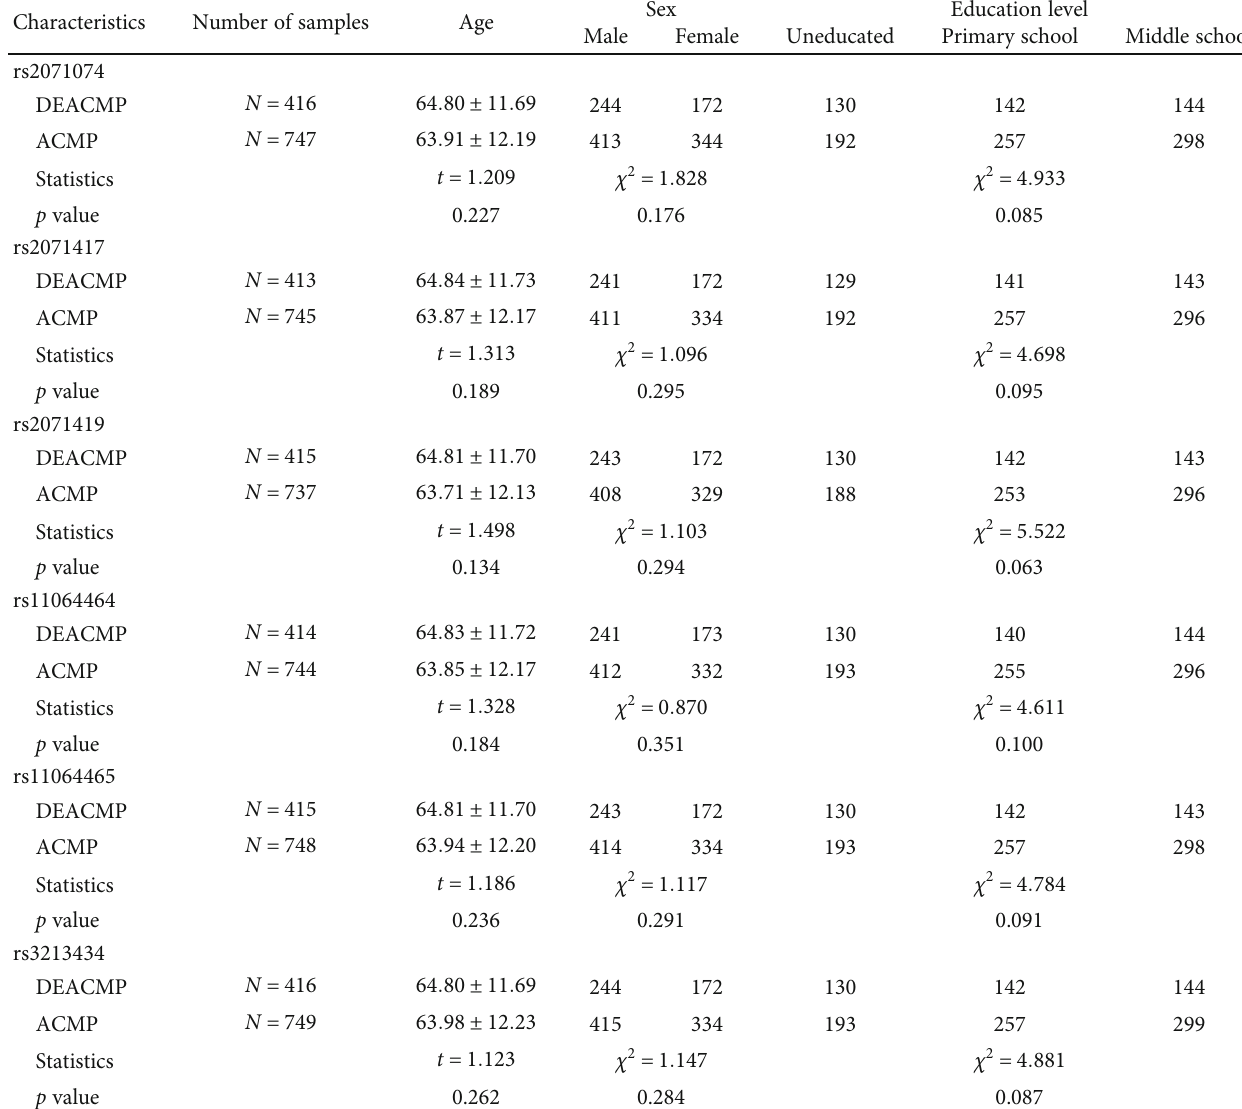
Table 2: Demographic variables of DEACMP and ACMP patients genotyped for the 6 SNPs (rs2071074, rs2071417, rs2071419, rs11064464, rs11064465, and rs3213434